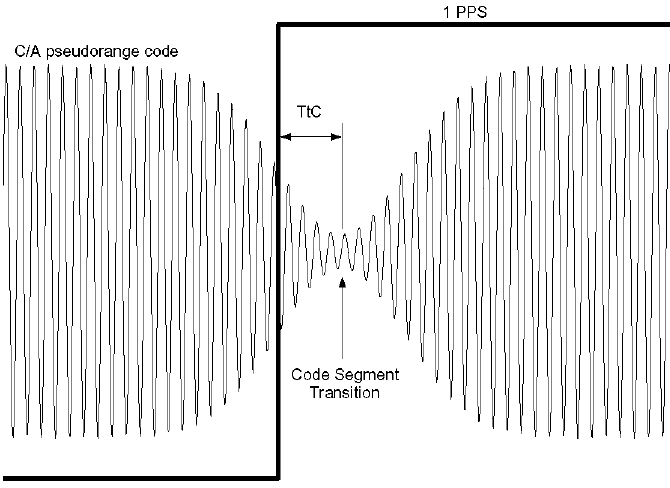
Figure 6. Measuring the TtC delay.